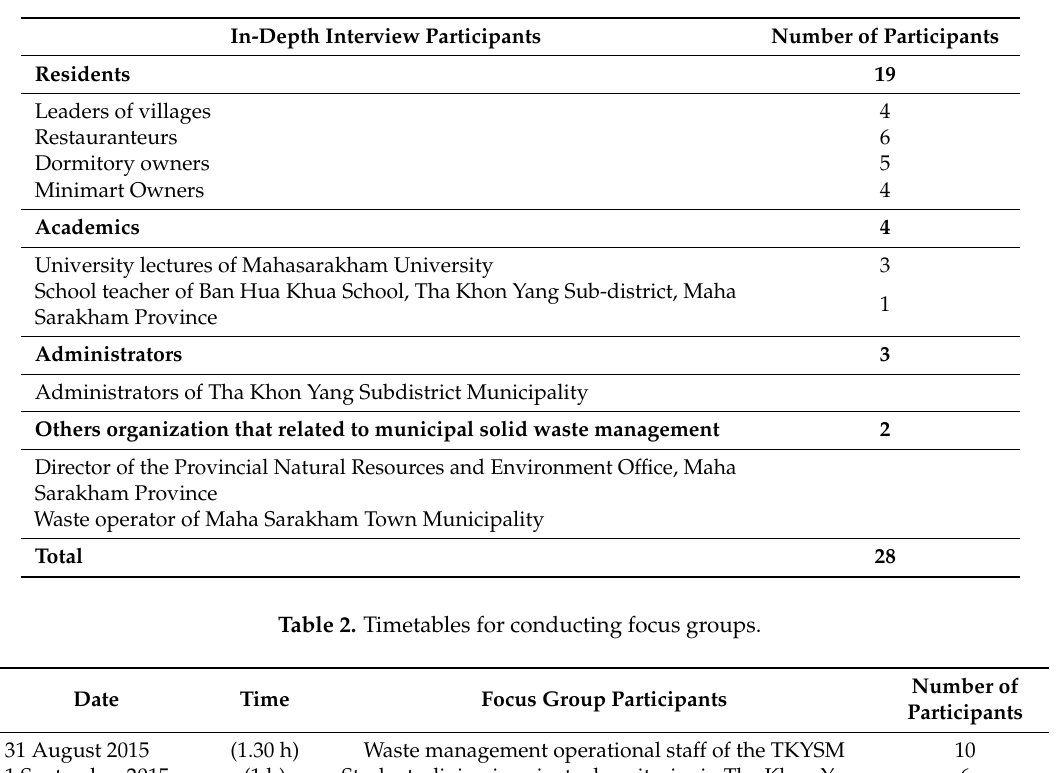
Table 1. In-depth interviews.